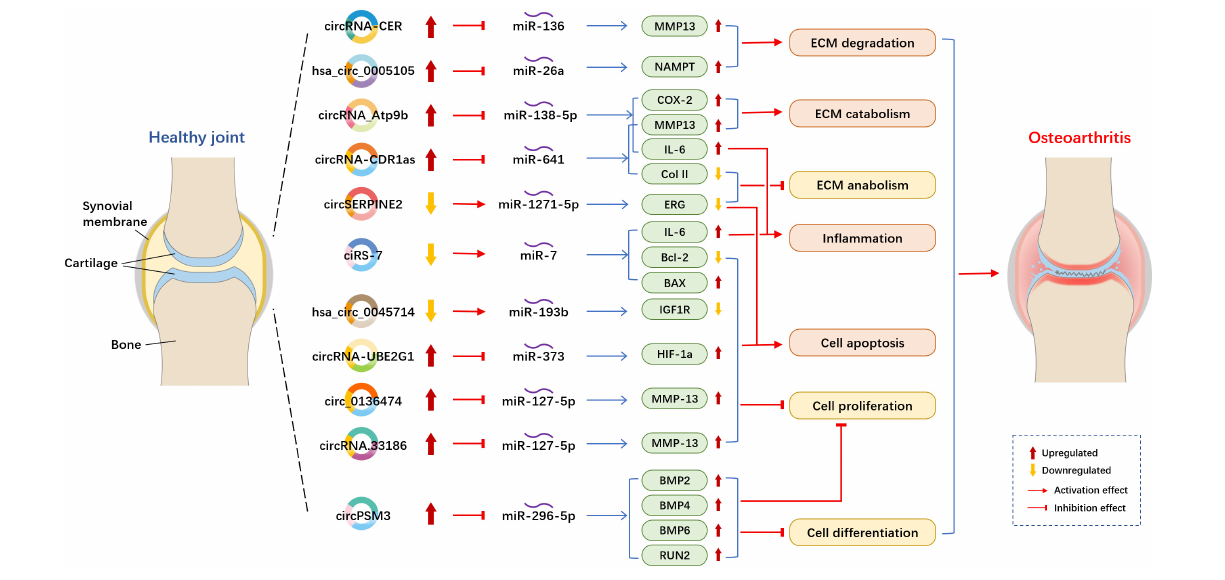
FIGURE 2 | Example of altered circRNA expression patterns and their biological effects in osteoarthritis. circRNA, circular RNA; ECM, extracellular matrix; MMP, matrix metallopeptidase; NAMPT, Nicotinamide phosphoribosyltransferase; COX-2, cyclooxygenase-2; IL-6, interleukin-6; Col II, type II collagen; ERG, E26 transformation-specific-related gene; BAX, BCL2 associated X, apoptosis regulator; Bcl-2, B cell lymphoma 2; IGF1R, insulin-like growth factor 1 receptor; HIF, hypoxia inducible factor; BMP, bone morphogenetic